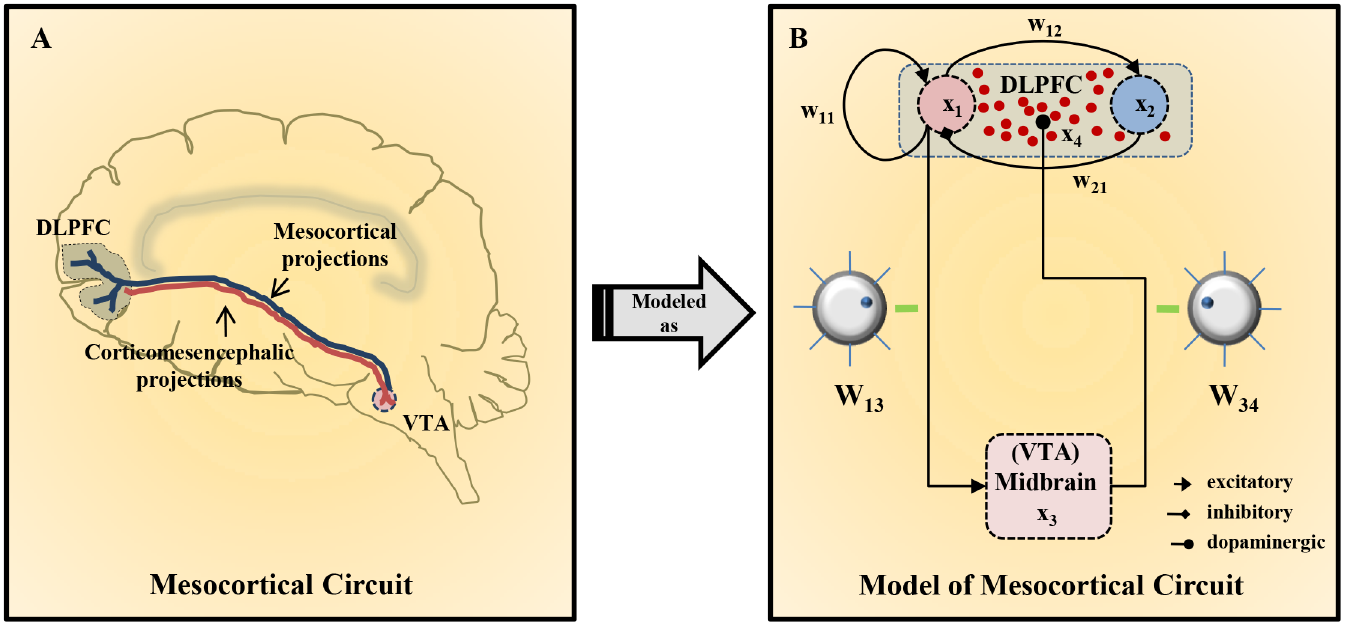
Fig 1. Schematic depiction of the Mesocortical circuit. (A) The interactions of the DLPFC and VTA in the central nervous system. DLPFC (grey region) innervates VTA nuclei (pink) located in the midbrain through corticomesencephalic glutamatergic projections (red). Reciprocally, VTA sends dopaminergic mesocortical projections (blue) to the DLPFC. (B) Detailed connection profile of various functioning modules in the mesocortical circuit. In the DLPFC, the group of pyramidal neurons, x 1 (red), excites itself through recurrent connections, with synaptic strength W 11 , as well as excites the group of GABAergic interneurons, x 2 (blue), with synaptic strength W 12 . In turn, the GABAergic interneurons, x 2 , exert a feed-back inhibition on the activity of pyramidal neurons, W x x x 1 , with synaptic strength 21 . Further, excitatory glutamatergic projections from pyramidal neurons, 1 , excite the group of dopaminergic neurons, 3 (pink), with the efficacy W 13 . On excitation, the dopaminergic projections from dopaminergic neurons, x 3 , release dopamine (dark red) in the DLPFC with the dopamine releasability W 34 . The dopamine pool in the DLPFC leads to D1 receptor stimulation and, accordingly, modulates the various parameters involved in cortical dynamics. The two parameters W 13 (efficacy of cortico-mesencephalic projections) and W 34 (dopamine releasability) govern the efficiency of cross-talk between DLPFC and VTA, and are shown as critical tuning knobs which can be easily rotated to different levels to observe their cumulative effect on the whole circuit dynamics.